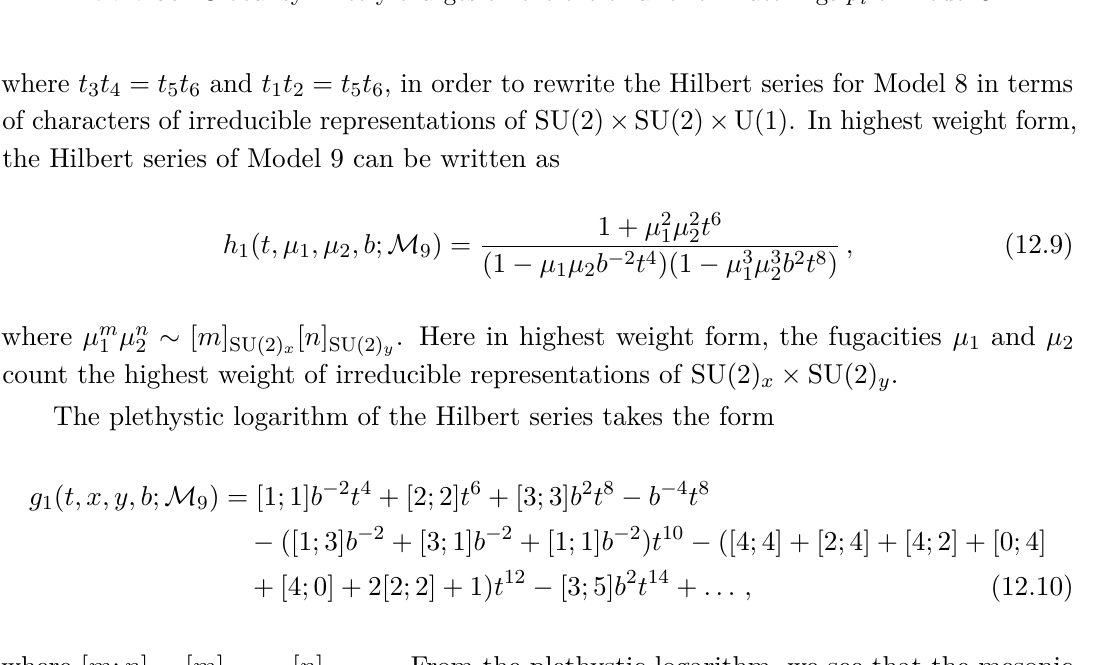
Table 35 . Global symmetry charges on the extremal brick matchings p i of Model